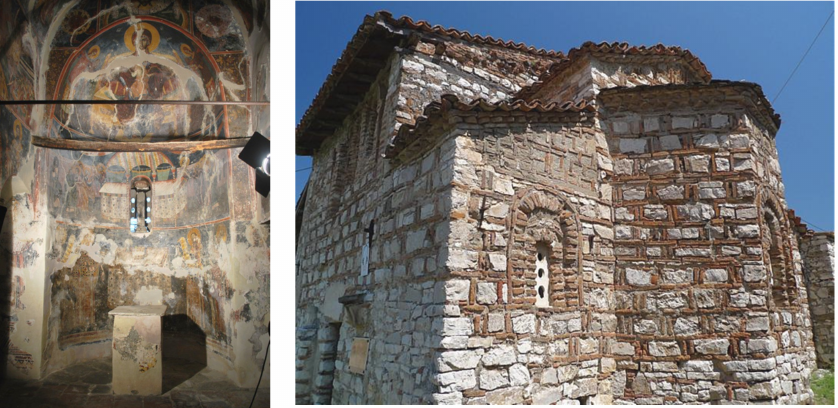
Figure 11. Internal ( left ) and external ( right ) views of St Mary of Blachernae’s church of